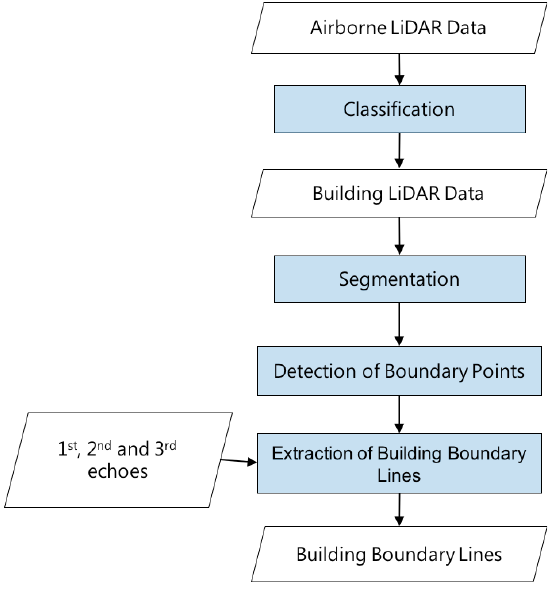
Figure 4. Flowchart of data processing of the proposed